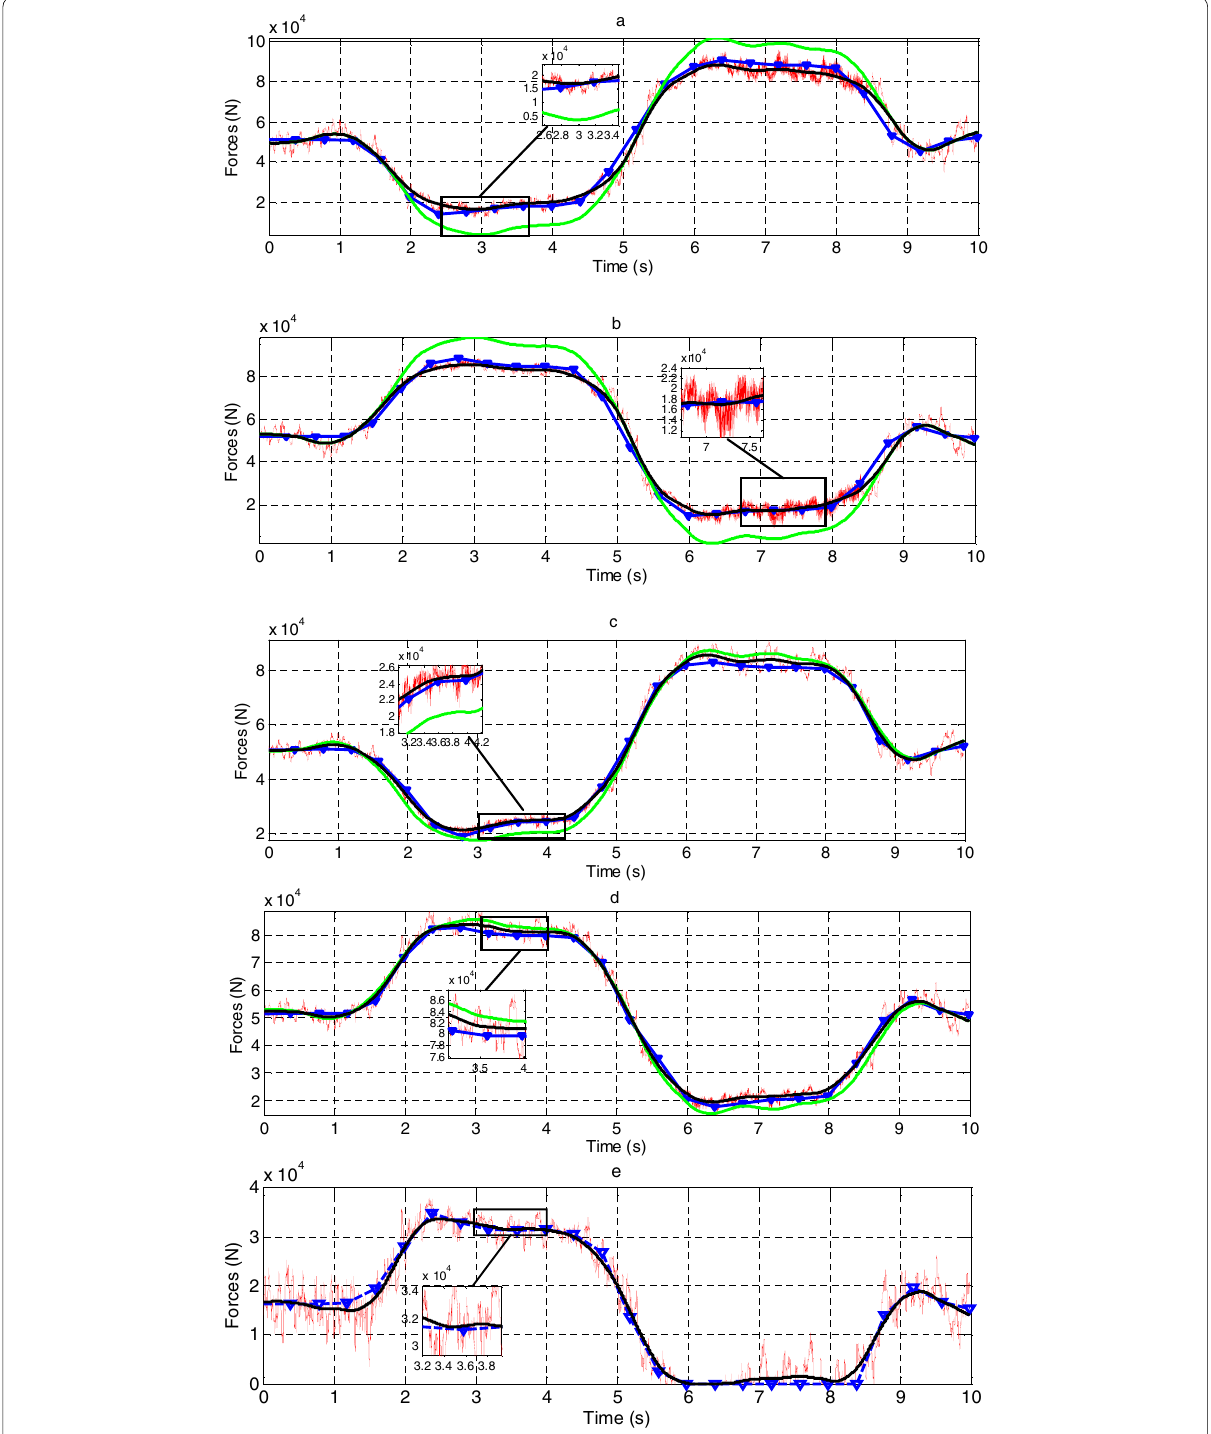
Figure 9 Comparisons between Trucksim and estimation under Condition